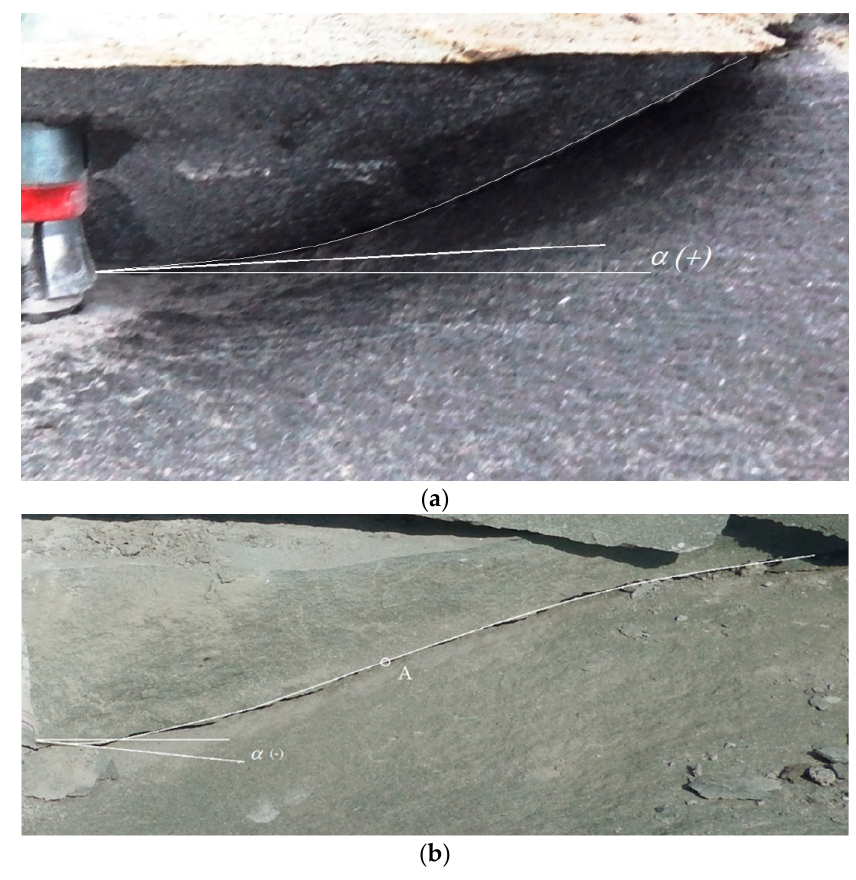
Figure 13. Failure trajectories of the rock medium: ( a ) Braciszów sandstone and ( b ) Brenna sandstone; α —initial angle of failure trajectory, A—inflection point of the failure trajectory.